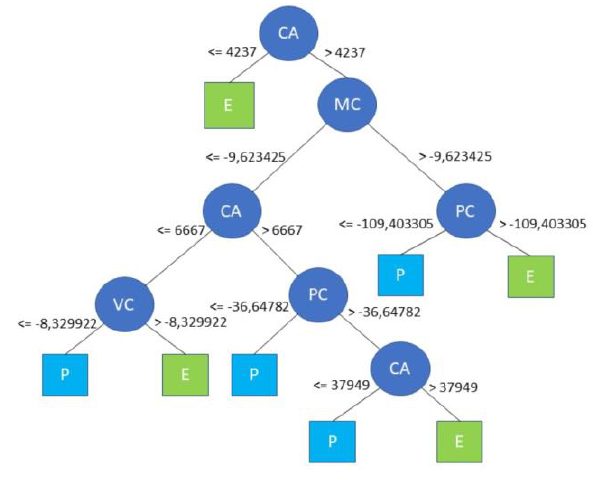
Figure 3 – Decision Tree for Classifying DEM-derived Raster Imagery.